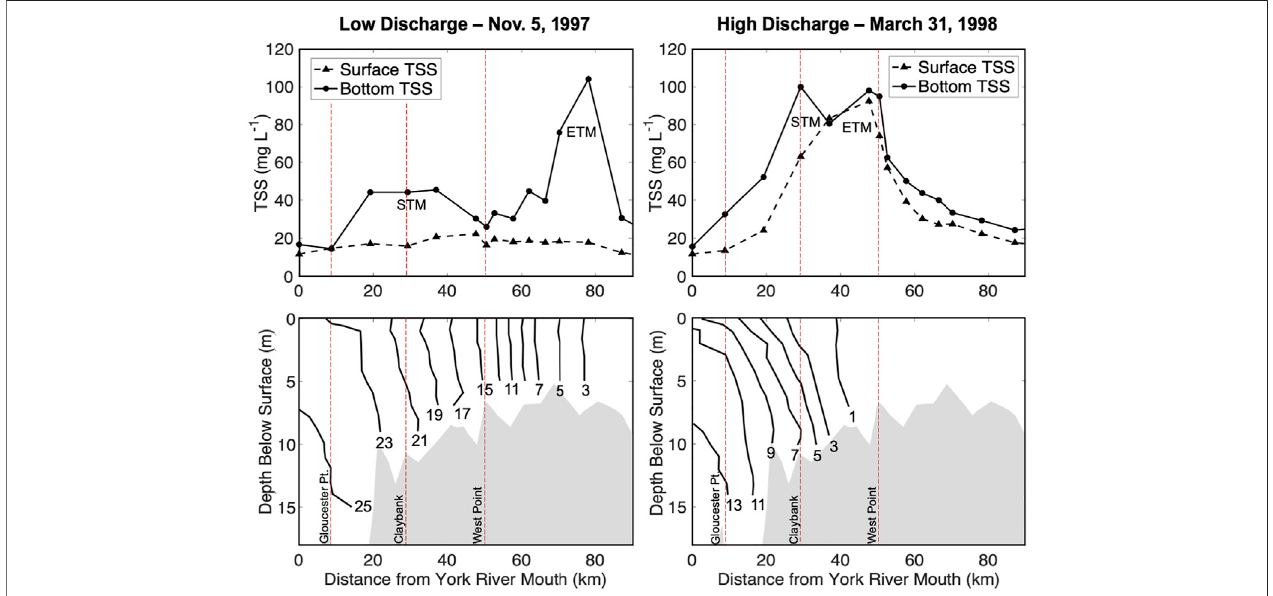
FIGURE 2 | Total suspended solids (TSS) collected 1-m below the surface and 1-m above the bottom (top panels) and salinity contours (bottom panels) along the York River estuary during low river discharge (left panels) and high river discharge (right panels) Adapted by permission from Springer Nature, Estuaries (Lin and Kuo, 2001), copyright